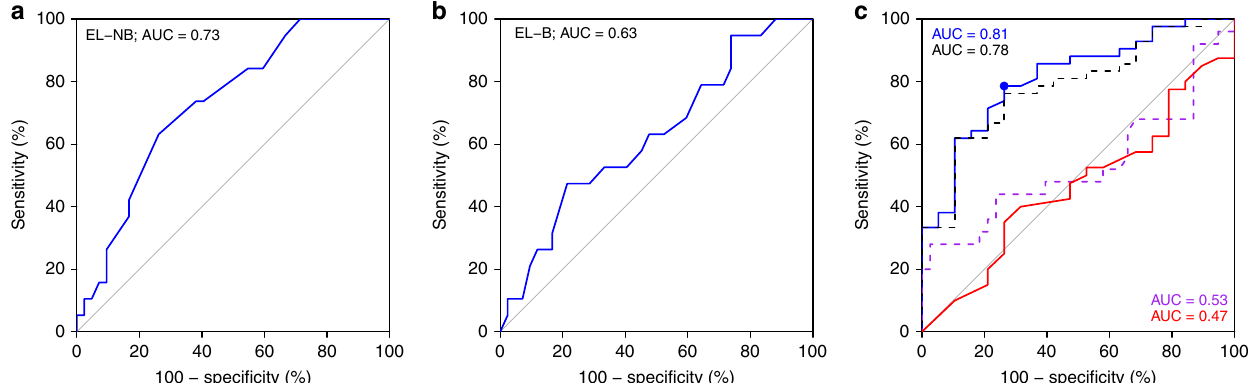
Fig. 5 Receiver operating characteristic (ROC) curves for the differentiation of chemotherapy + trastuzumab (C + T) or trastuzumab monotherapy (T) B and NB cases using histological scores from poly-ligand pro fi ling (PLP) with libraries EL-NB and EL-B in the test set of 61 cases. a ROC curve obtained based on EL-NB library PLP scores. AUC 0.73, p = 0.01. b ROC curve obtained based on EL-B library PLP scores. AUC 0.63, p = 0.11. c ROC curves obtained based on combined PLP scores of EL-NB and EL-B libraries using a logistic regression algorithm (blue curve, AUC = 0.81, p = 0.0007); black dashed curve: 10-fold cross-validation on the combined scores of EL-NB and EL-B libraries (AUC = 0.78, p = 0.002), 10-fold cross-validation was run 100 times and the average predictive score was used as the fi nal cross-validation result; red curve: AUC values obtained by HER2-IHC scoring of the same 61 cases (AUC = 0.47); purple dashed curve: performance of the combined libraries on 63 HER2 cases independent from the test set who received platinum/taxane combination therapy instead of trastuzumab (AUC = 0.53). TTNT data for these patients are unrelated to trastuzumab-based